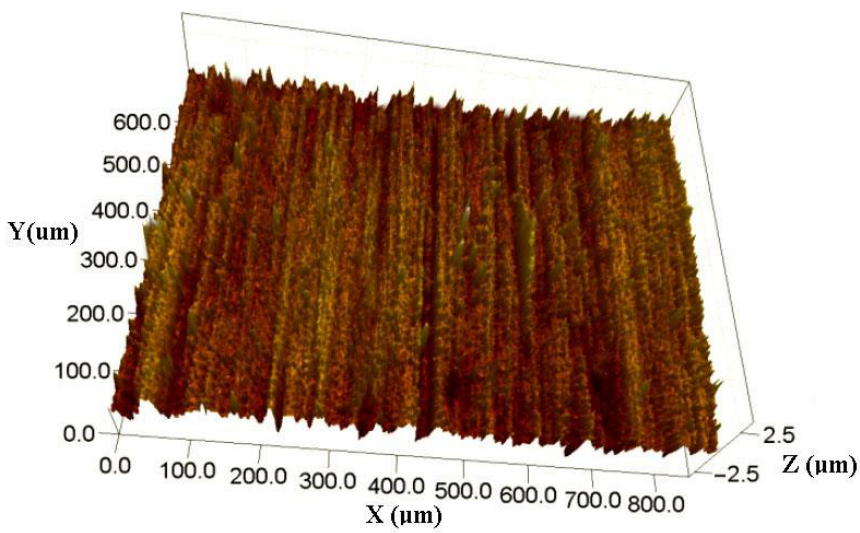
Figure 6. WLIP picture of the Ni–TiN nanoplating.